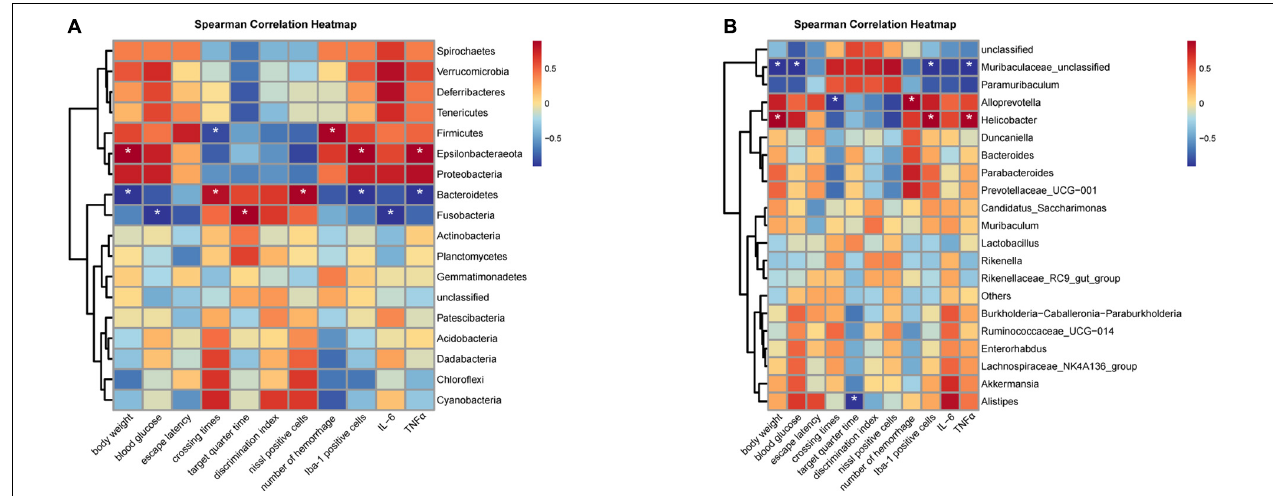
FIGURE 8 | Heatmaps showing correlations between phenotypes and gut microbiota. (A) Correlation analysis at the phylum level. (B) Correlation analysis at the genus level. ( n = 6 per group); * P <